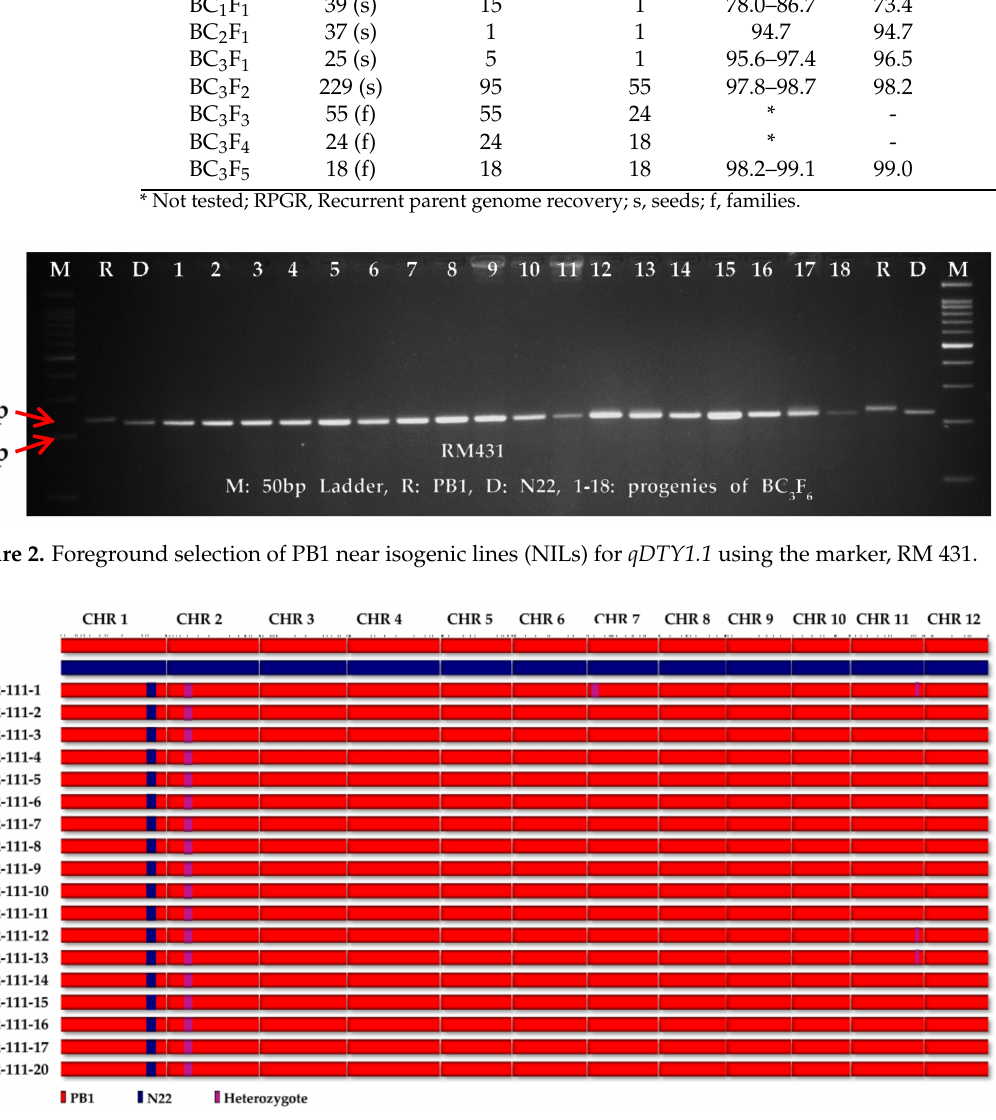
Figure 3. Graphical representation of the genotypes of 18 qDTY1.1 introgressed NILs of PB1. All the NILs had maximum recovery on the carrier chromosome 1. CHR: